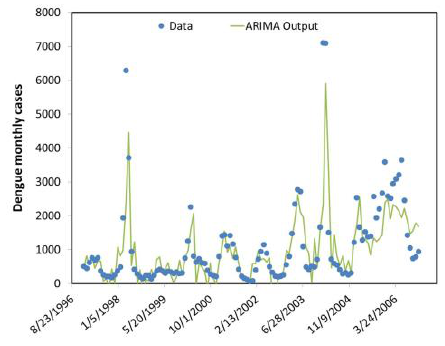
Figure 2. Modelled dengue cases in Jakarta, Indonesia